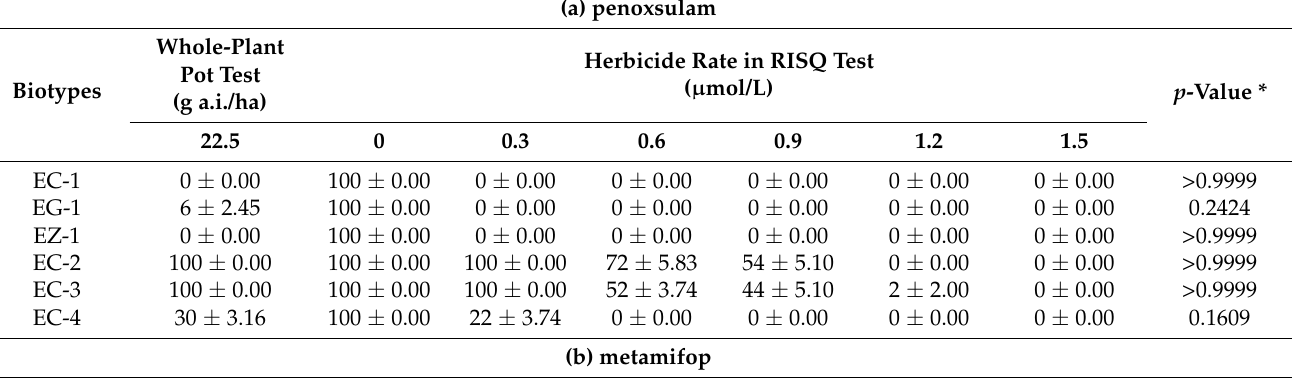
Table 7. The percentage surviving in the RISQ test compared with whole-plant pot tests for different susceptible and resistant Echinochloa spp. biotypes treated with (a) penoxsulam, (b) metamifop, and (c) quinclorac. (a)